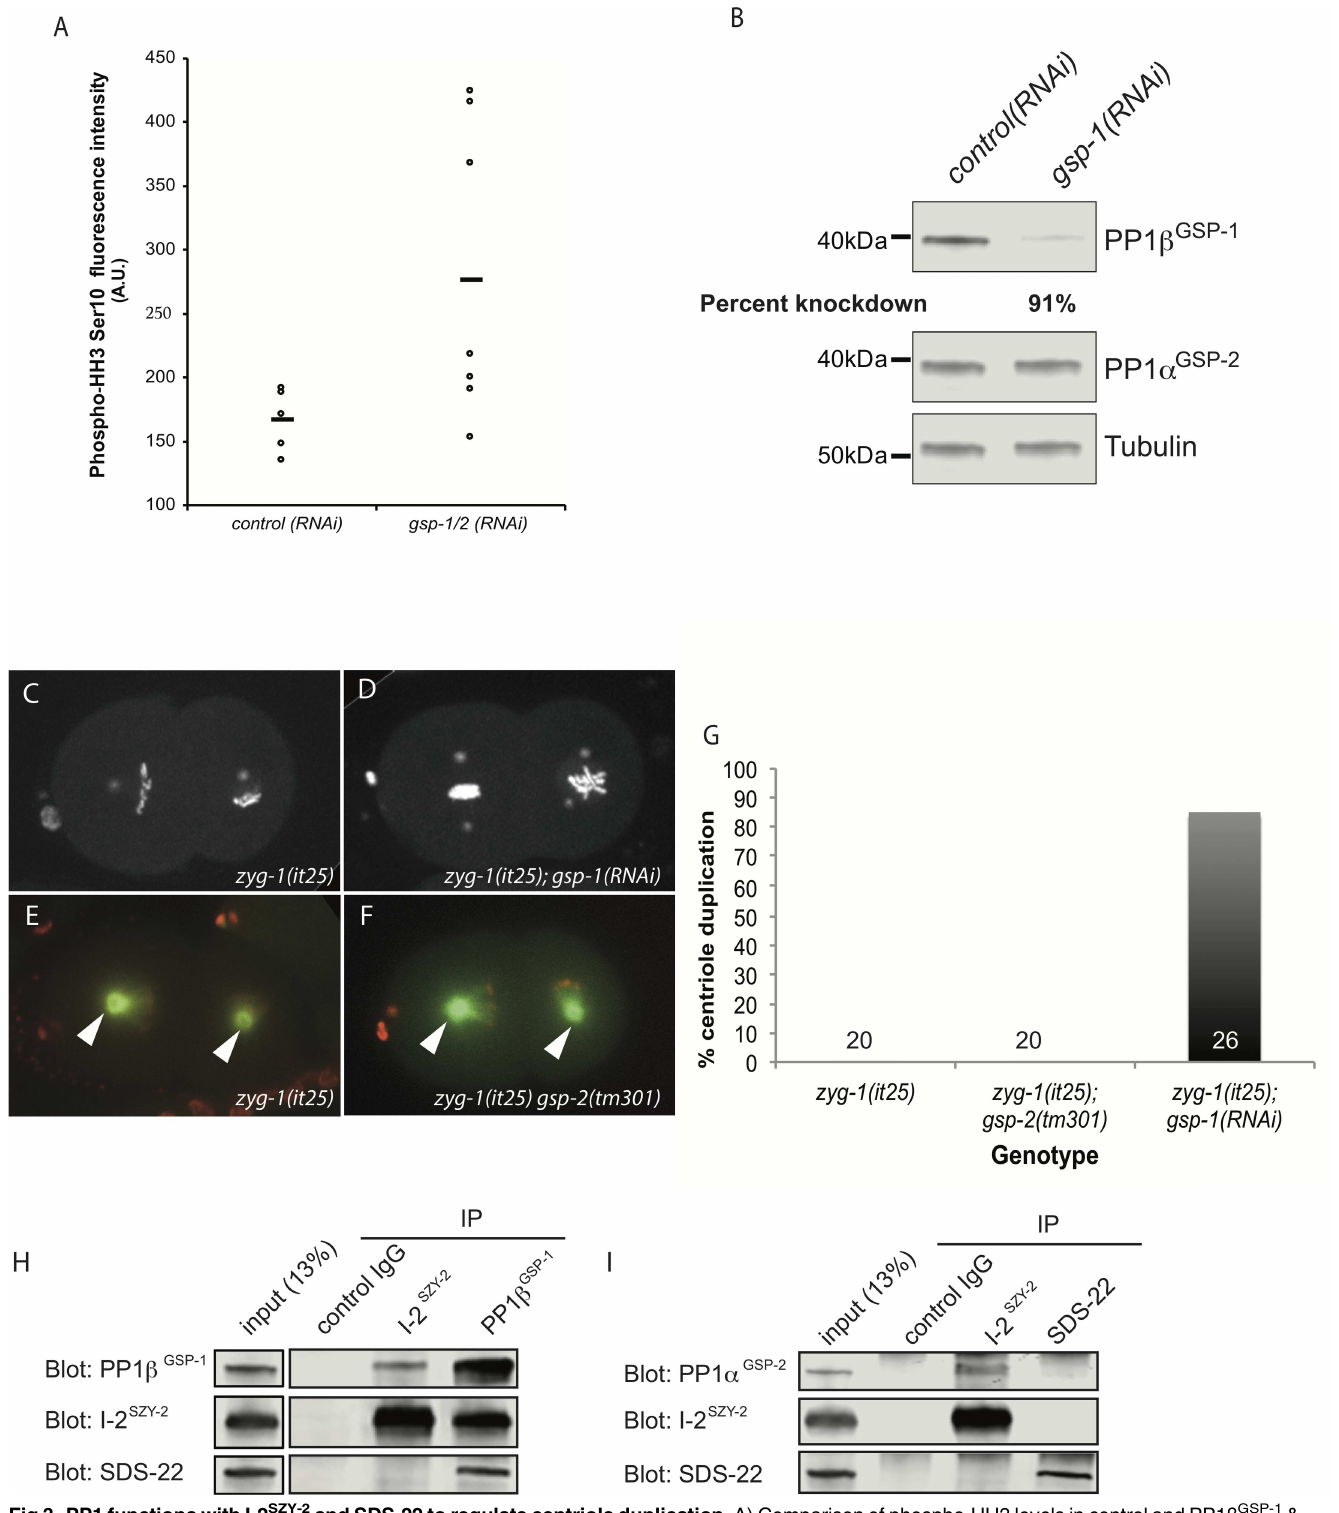
Fig 3. PP1 functions with I-2 SZY-2 and SDS-22 to regulate centriole duplication. A) Comparisonof phospho-HH3 levels in control and PP1 β GSP-1 & PP1 α GSP-2 co-depletedembryosas determined by quantitative immunofluorescencemicroscopy. The mean is indicatedby the bar. B) Western blot demonstrating specificity of gsp-1(RNAi) . C&D) Stills from time-lapse recordingsof embryos of the indicatedgenotypes, expressingGFP::histone